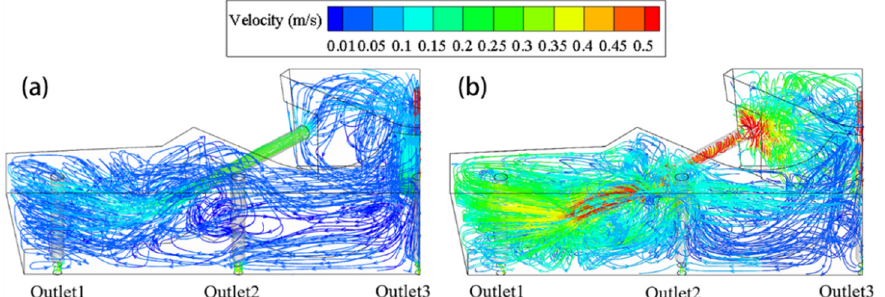
Figure 12. Three-dimensional (3D) streamline comparison of case S0: ( a ) without induction heating; ( b ) with induction heating.